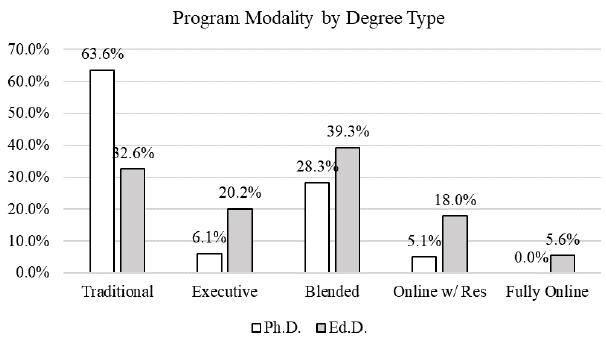
Figure 3. Program Modality by Degree